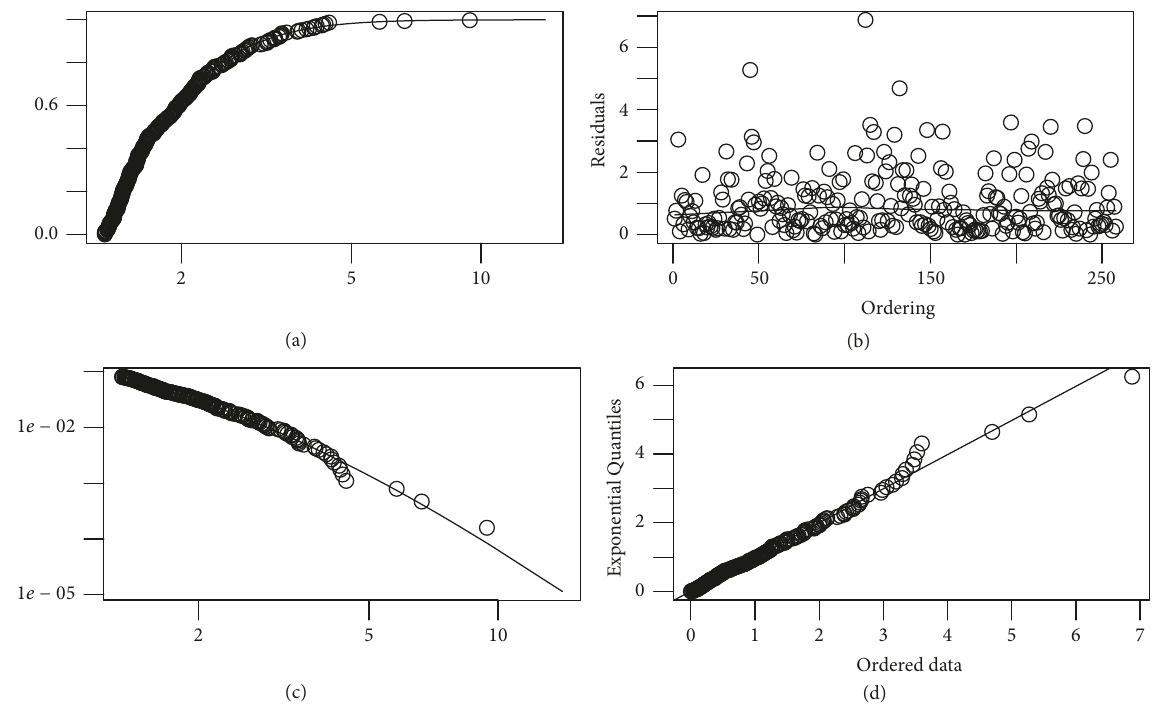
Figure 5: The test chart of the logarithmic yield of gold GDP diagnostic.